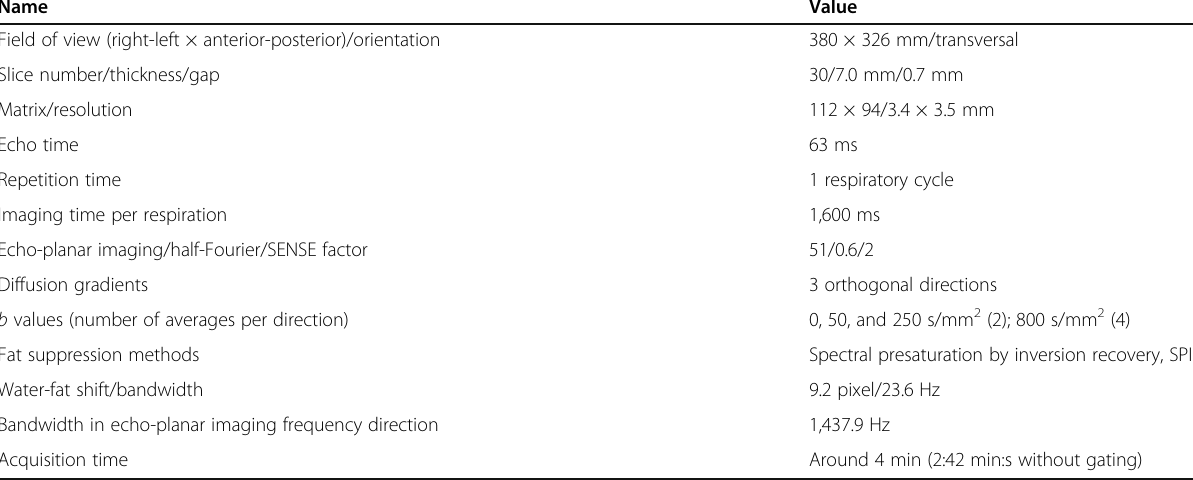
SENSE Parallel imaging with sensitivity